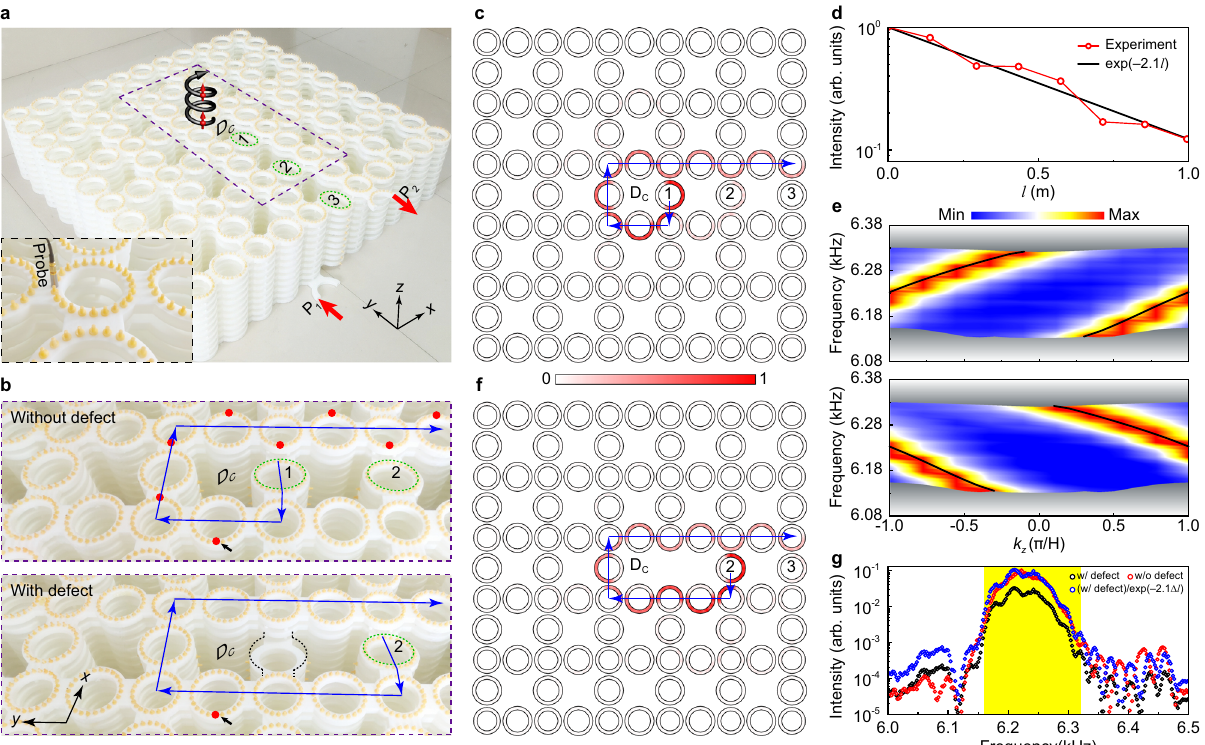
Fig. 3 Experimental characterizations of the acoustic TDMs and their topological robustness to defects. a Experimental setup. For clarity, three tilted ring-waveguides on the top layer are numbered and the termination of the screw dislocation is labeled with D C . The ports P 1 and P 2 are inlet and outlet of sound, respectively. The inset ampli fi es the details of the top layer, on which subwavelength holes are perforated for inserting the sound probe. b Top panel: Zoom-in photograph for the area marked by the purple dashed box in ( a ), where the blue arrows indicate the propagations of the TDMs after leaving the screw dislocation. Bottom panel: The same as the top panel, but with a defect (outlined by the black dashed lines) created near D C . c Pressure amplitude pattern scanned on the top layer at 6.27 kHz, which visualizes the presence of TDMs. d Sound intensity (red circles) measured at 6.27 kHz for a sequence of sites along the dislocation path (red dots in the top panel of b ). The black line shows an exponential fi t, where l is the propagation length measured from the fi rst site, i.e., the red dot speci fi ed with a black arrow. e Top panel: Measured dispersion for the 1D TDMs (bright color), which captures precisely the simulation result (black lines). Bottom panel: The same as the top panel, but the sound is injected from the port P 2 and leaves from the port P 1 . f The same as c , but for the system with a defect. g Sound intensity spectra detected at the sites speci fi ed by black arrows in b for the systems with and without a defect. 4 l ¼ 0 : 56 m is the extra propagation length of the TDMs induced by the